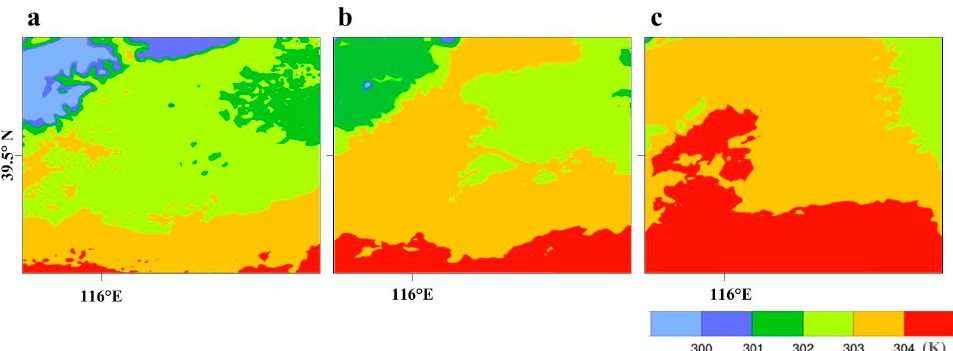
Figure 2. Average air temperature (k) at 2 m for different land cover during the daytime. ( a ) no urban cover (NU), ( b ) current urbanization cover (CU), and ( c ) full urban land cover (FU).